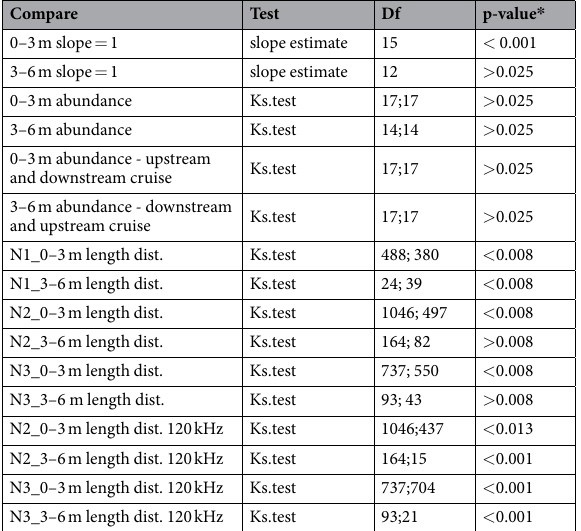
Table 3. Statistical results for juvenile abundance and size comparison between methods. N1, N2 and N3 refer for night 1, night 2 and night 3, Ks.test refers to Kolmogorov – Smirnov test, dist. – distribution, * Bonferroni correction (0.025, 0.0125, 0.0083, respectively 2, 4, 6 same